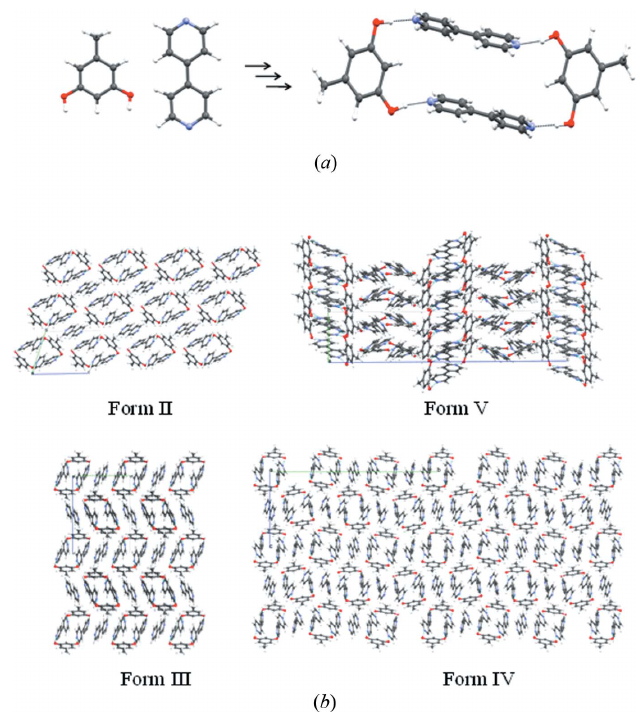
Figure 9 ( a ) Molecular recognition based on O—H (cid:2)(cid:2)(cid:2) N hydrogen bonds and the formation of synthon B . ( b ) Various topologies of forms II through to V , anticlockwise, based on synthon B